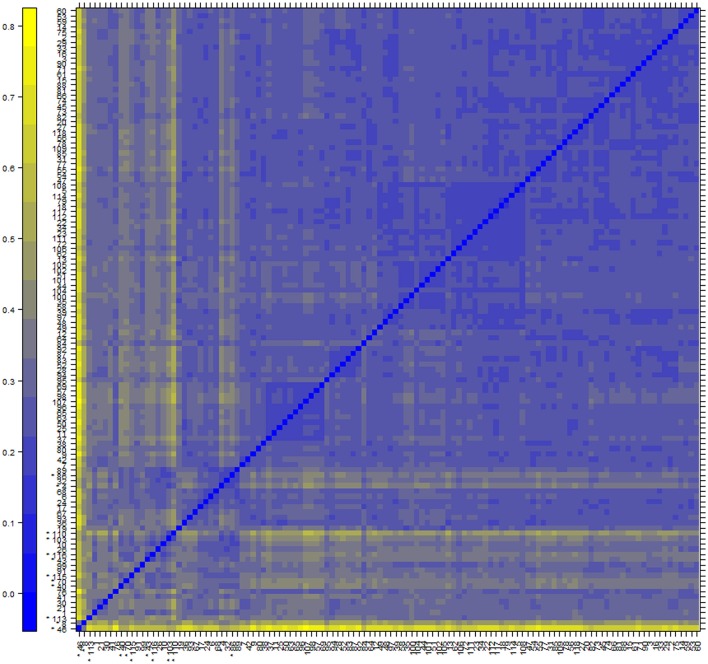
Normalization and analysis of array quality metrics shows a color heatmap of the distances between arrays. The color scale is chosen to cover the range of distances encountered in the dataset. Patterns in this plot can indicate clustering of the arrays either because of intended biological or unintended experimental factors (batch effects). The distance dab between two arrays a and b is computed as the mean absolute difference (L1-distance) between the data of the arrays (using the data from all probes without filtering). In formula, dab = mean | Mai - Mbi |, where Mai is the value of the i-th probe on the a-th array. Outlier detection was performed by looking for arrays for which the sum of the distances to all other arrays, Sa = Σb dab was exceptionally large. 12 such arrays were detected, and they are marked by an asterisk, *.